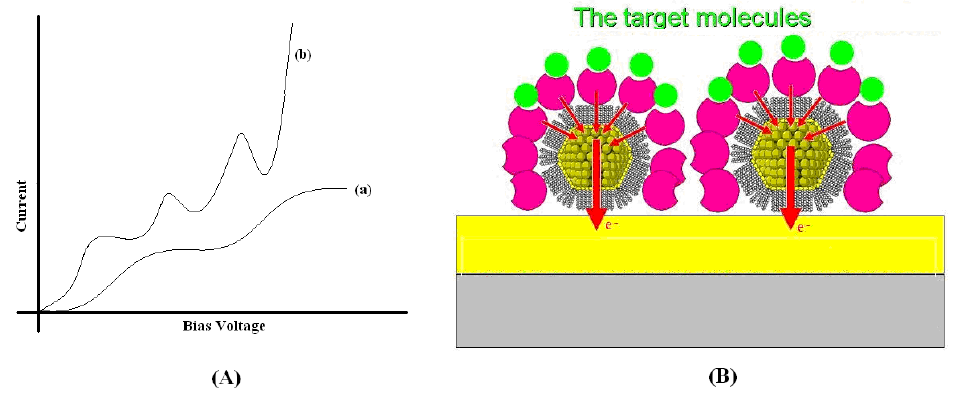
Figure 9. (A) Schematic curves showing staircase curve (a) and curve with oscillations (b) related to charge trapping within a quantum-dot. (B) Schematic model describing the role played by thiols capped gold nano-particles in electron-transfer between cytochromes and